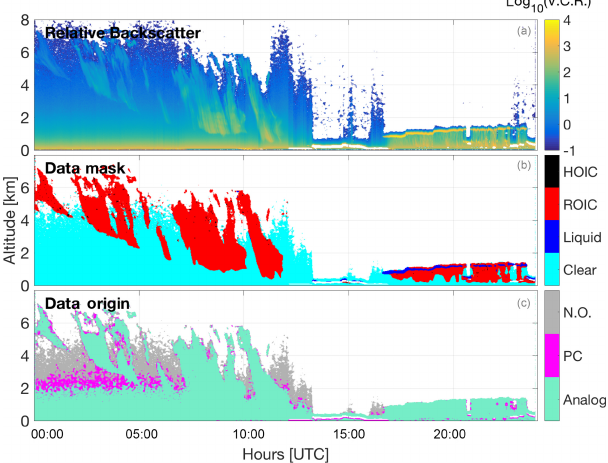
Figure 4. A sample of the CAPABL merged data product from 22 August 2016. Panel (a) shows total analog backscatter for the whole day in log base 10 signal intensity. Panel (b) shows the merged data product. Panel (c) shows the origin of each voxel. Analog indicates orthogonal processing with analog data, PC in- dicates orthogonal processing with photon counting data. All non- orthogonal types are lumped together as